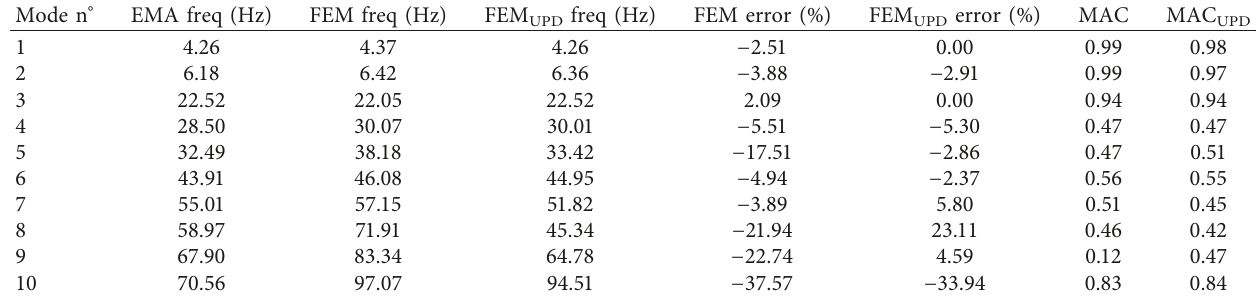
Table 1: Frequency and MAC discrepancies between the numerical and the experimental models before and after the model updating